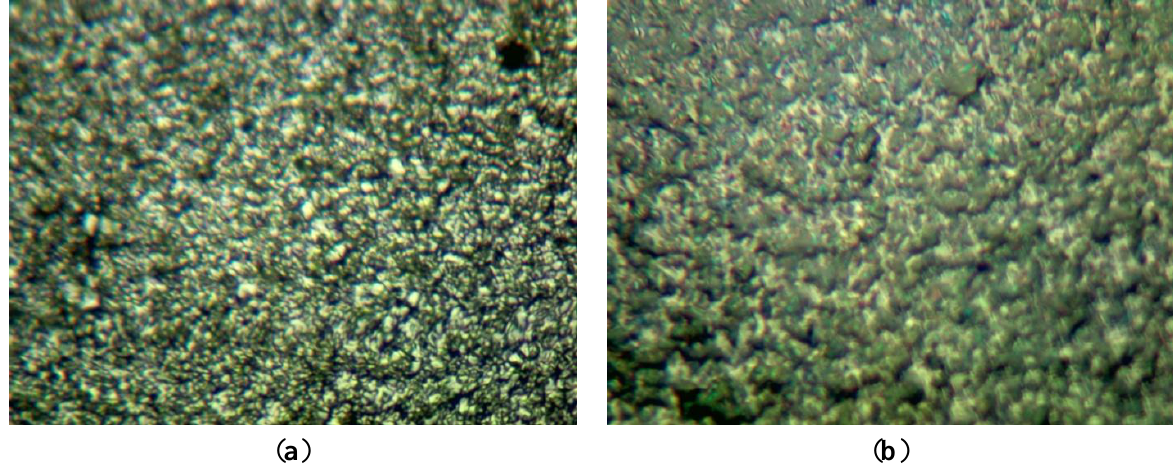
Figure 10. Photographs of optical microscope of microbalance surface magnified by 1200 times: ( a ) blank; and ( b ) PVA coated.